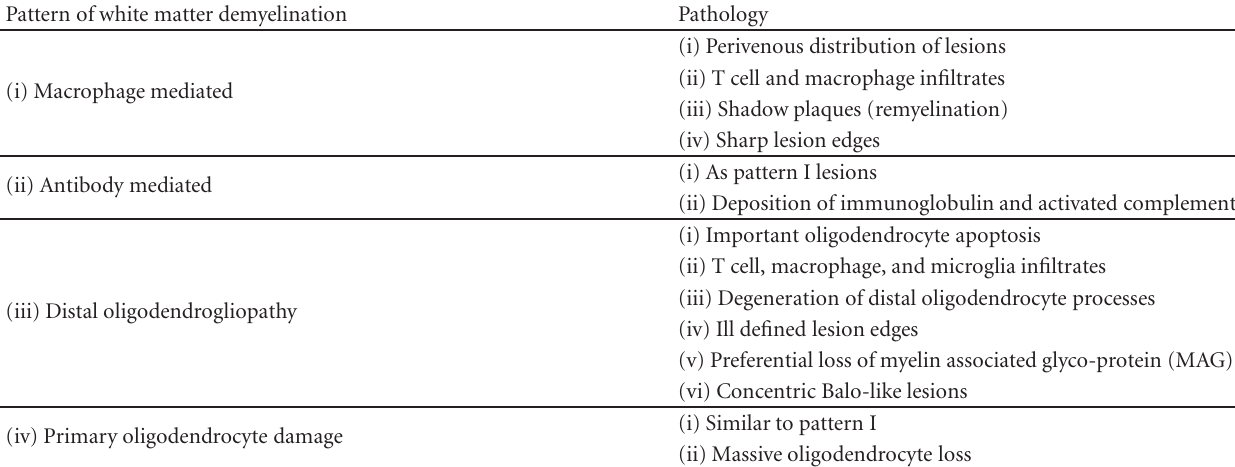
Table 4: Patterns of demyelination described by Lucchinetti et al. 2000 [7].